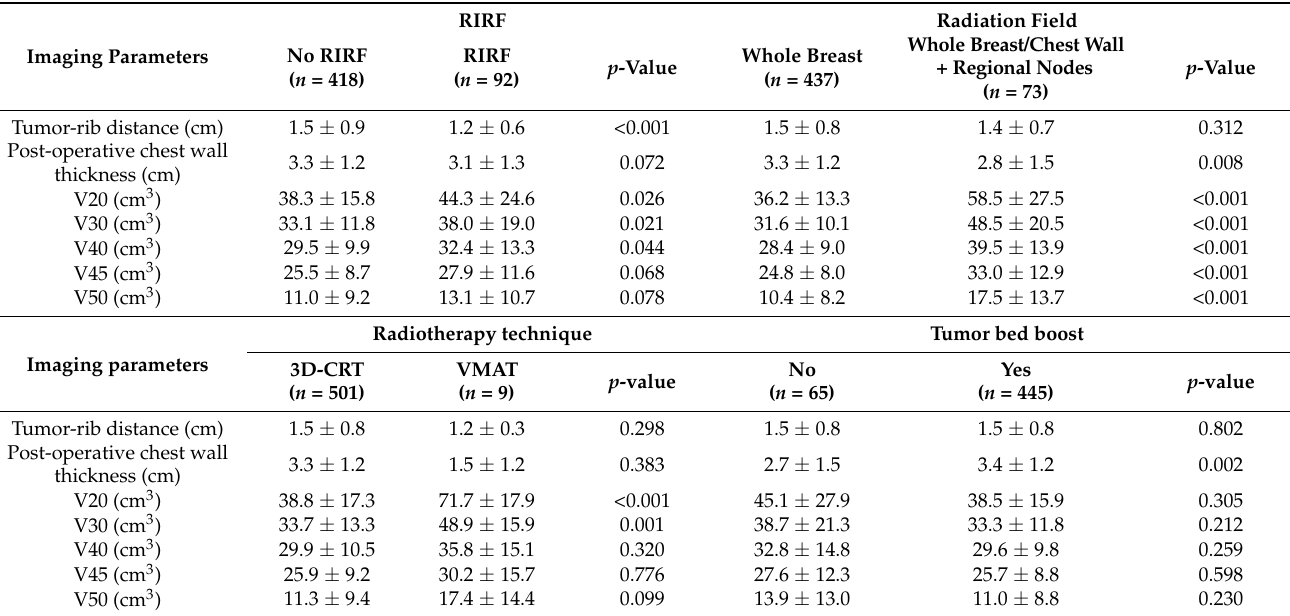
Table 2. Comparison of tumor-rib distance, post-operative chest wall thickness, and absolute rib volumes receiving more than 20 Gy (V20), 30 Gy (V30), 40 Gy (V40), 45 Gy (V45), and 50 Gy (V50) according to the RIRF, surgery type, and radiation field.